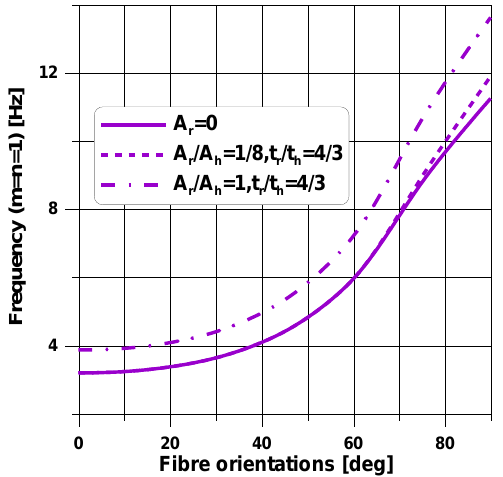
Figure 11. The effects of patch reinforcement on the distributions of eigenfrequencies—angle-ply plate (FFFC, L x / L y = 4).